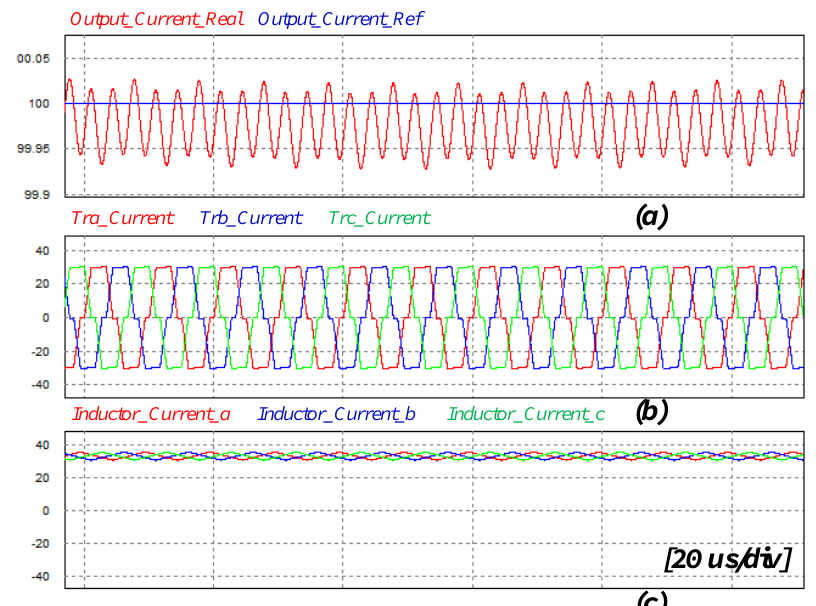
Figure 15. Simulation results of charging operation ( a ) real output current and reference output current, ( b ) three phase transformer current of the secondary side, and ( c ) three phase inductor current.